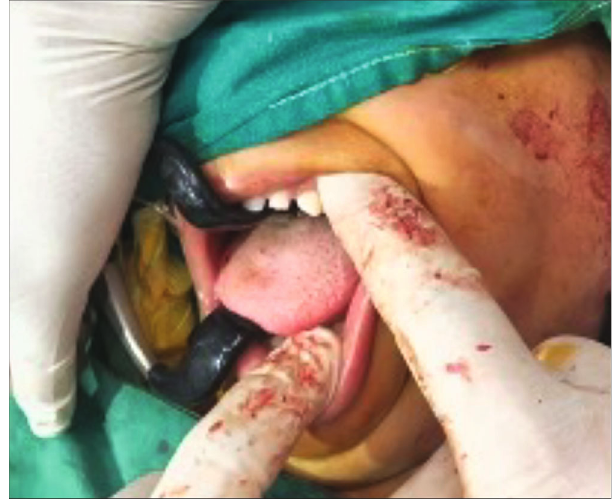
Figure 9: Inter-incisal opening following removal of the ankylotic mass.